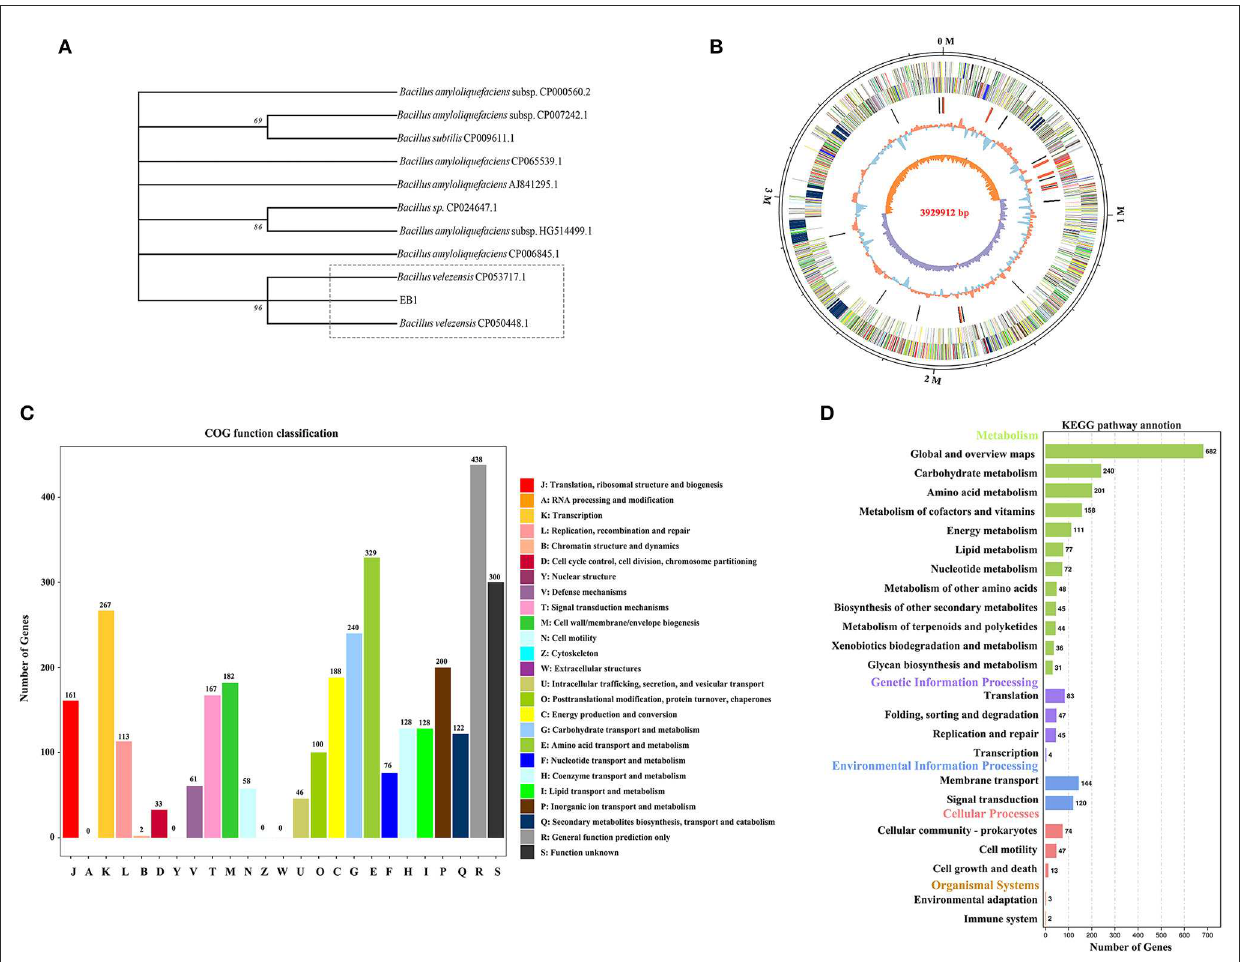
FIGURE2 Phylogenetic and genomic analyses of strain EB1. (A) Phylogenetic trees of strain EB1 based on 16S rRNA gene. The tree was constructed using the MEGA software. The level of bootstrap support (1,000 repetitions) was indicated at all nodes. (B) Graphical circular map of EB1 genome. The distribution of the circle from the outermost to the center is (i) scale marks of the genome; (ii) protein-coding genes on the forward strand; (iii) protein-coding genes on the reverse strand; (iv) tRNA (black) and rRNA (red); (v) GC content; (vi) GC skew. (C) The COG annotation of strain EB1 genome. (D) The KEGG pathway annotation of strainEB1